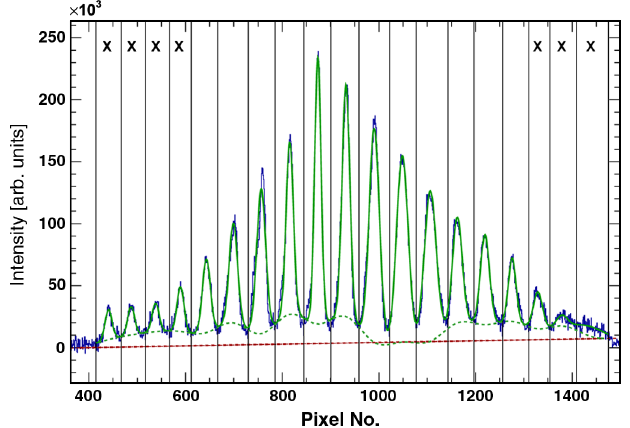
FIG. 4. Histogram of the horizontal projections ( 1 pixel ¼ 6 : 15 (cid:1) m ) of all pepper-pot beamlets (blue line), only 90% of the core beam is taken into account for emittance evaluation and rejected beamlets are indicated with a cross. The green line corresponds to the multi-Gaussian fits assuming a local back- ground (dashed green line) to avoid beamlet overlap effects. The red dashed line corresponds to the background without beam. ¼ 510 kV ; g ¼ 6 mm ; z ¼ ( (cid:5) mc 2 ¼ 6 : 35 MeV ; 200 pC; V pulser ¼ 3 ps , Gaussian time profile; D ¼ 0 : 9 mm ; 2 : 3 m ; (cid:2) t; laser laser ¼ 1 : 3 (cid:3) 0 : 2 (cid:1) m " nX